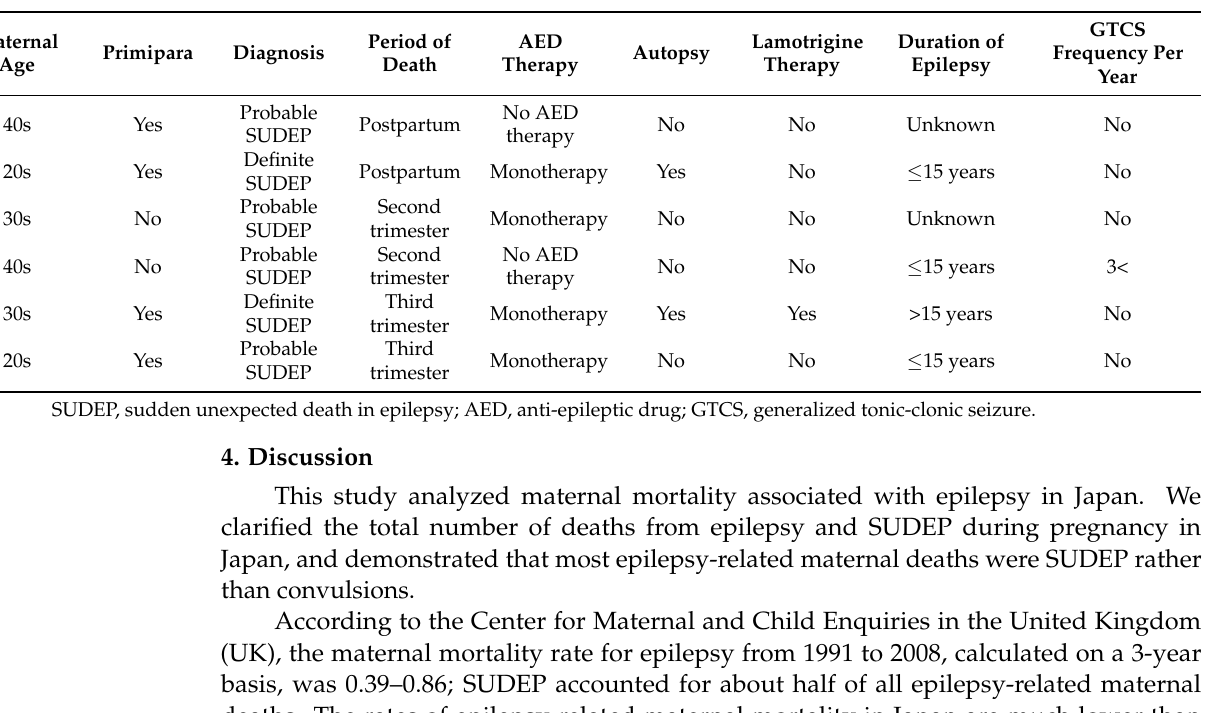
Table 2. The characteristics of maternal death cases related to